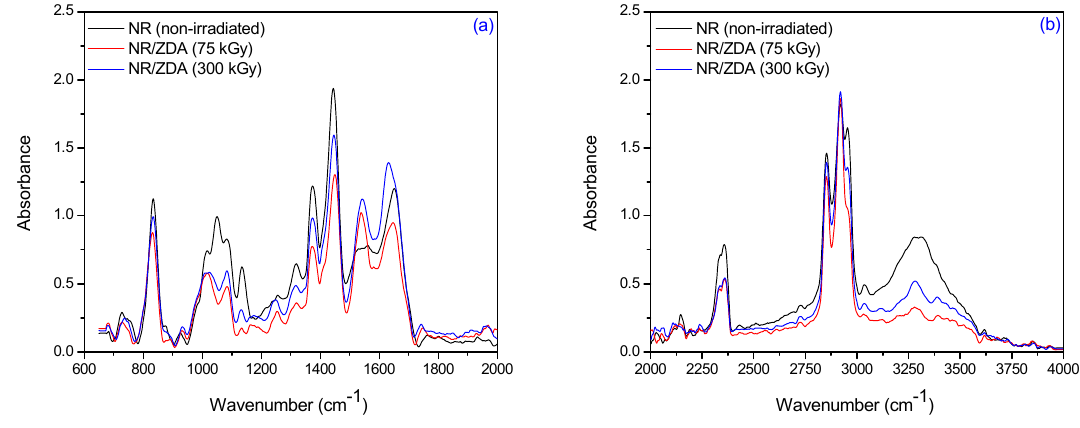
Figure 11. FTIR spectra in the range of ( a ) 2000 cm − 1 –600 cm − 1 and ( b ) 4000 cm − 1 –2000 cm − 1 for NR/ZDA irradiated at 75 kGy and 300 kGy.